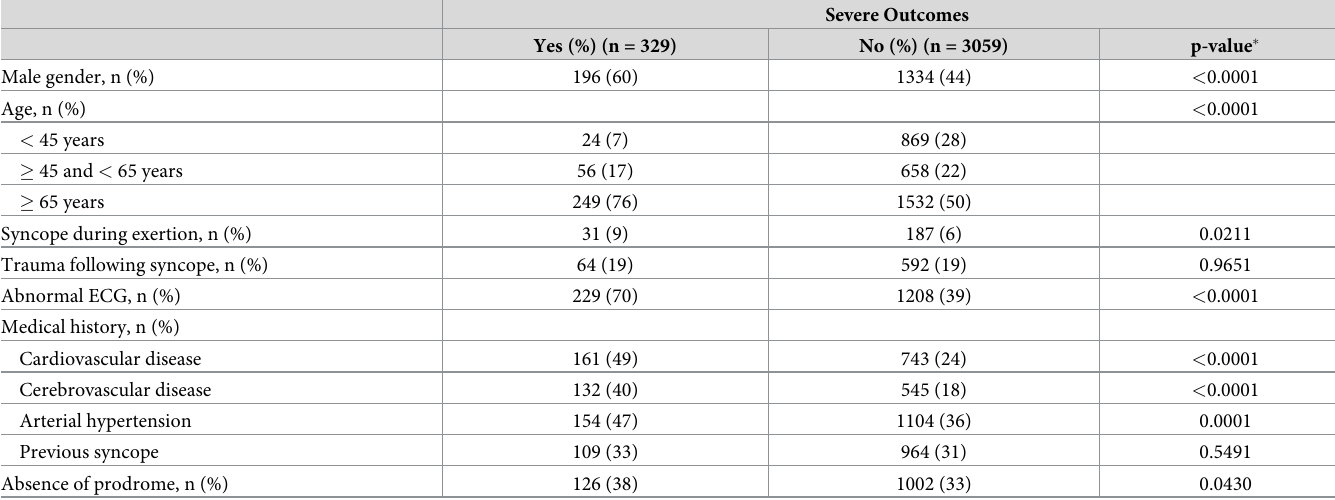
Table 2. Risk factors for severe short-term outcomes within 10 days (univariate analysis).